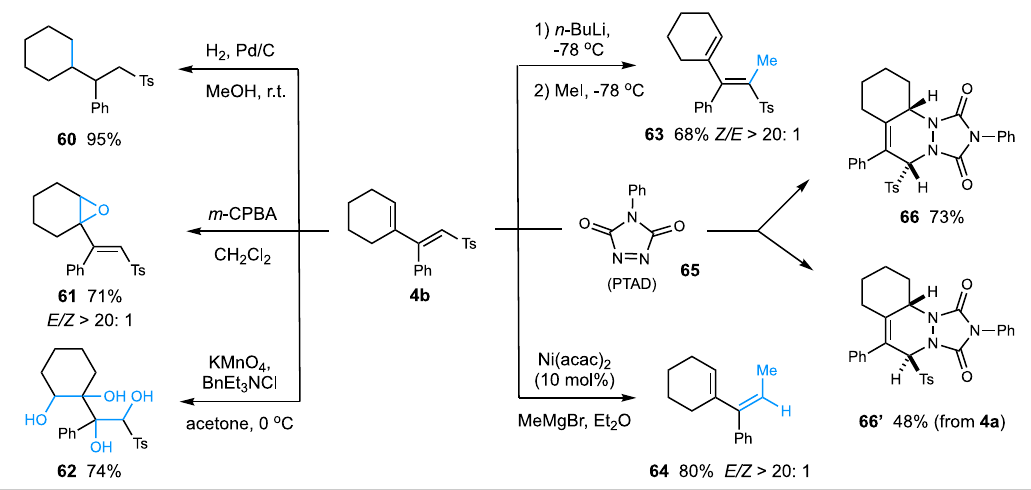
Fig. 3 | Synthetic applications. a Stereodivergent access to complex sulfonyl 1,3-dienes; b Synthetic transformations of sulfonyl 1,3-dienes. m -CPBA = m - chloroperoxybenzoic